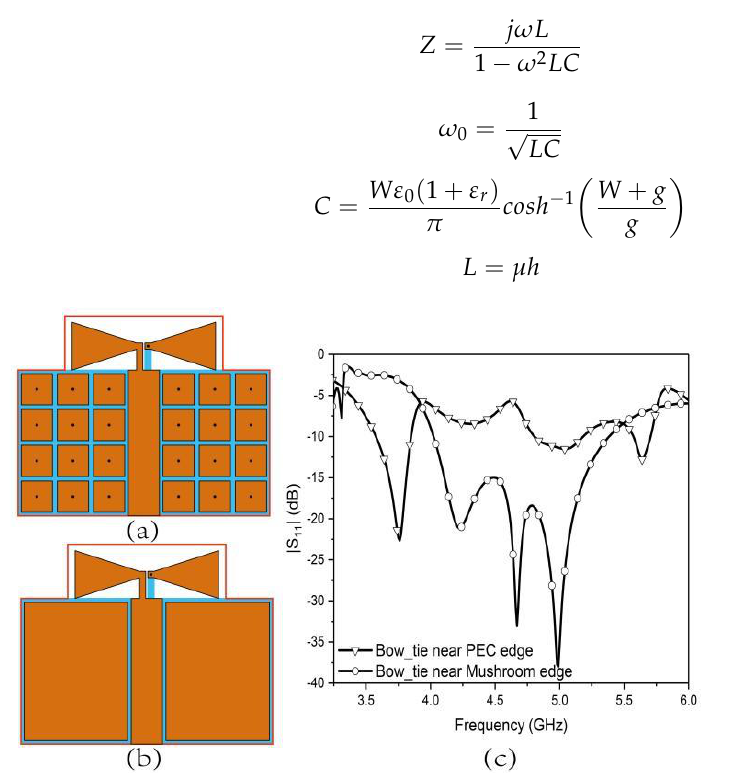
Figure 4. Geometries of ( a ) bow-tie radiator near mushroom edge and ( b ) bow-tie radiator near PEC edge. ( c ) Simulated return losses of ( a , b ).